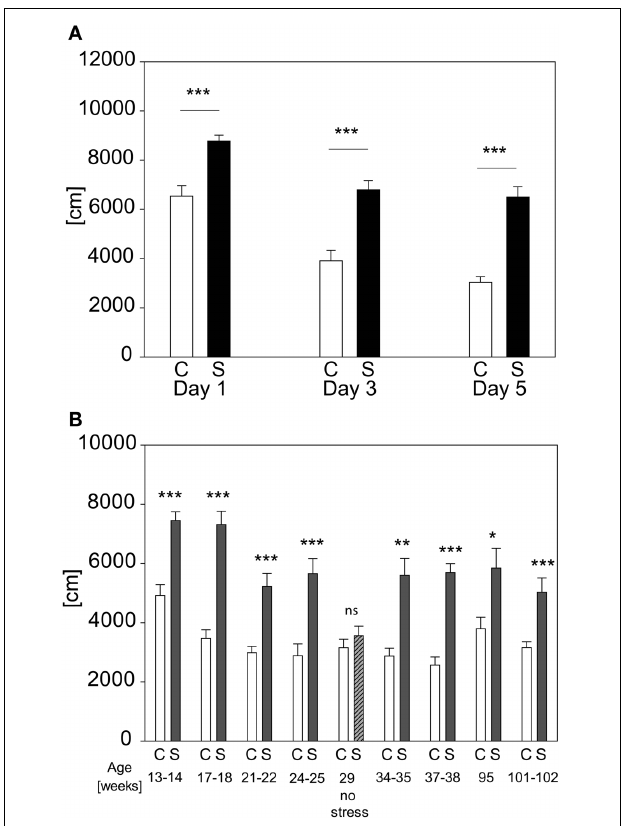
FIGURE 9 | Female and 2 year old male C57BL/6 and different inbred strains. (A) Female C57BL/6J mice were tested with the 2h restraint stress test. In both exposures females showed the expected increase in distance traveled. Aged C57BL/6J males also showed the increase in distance traveled. (B) BALB/c, C3H and 129S wildtype males were also tested with the 2h acute stress test. All of these strains demonstrated a lower locomotor activity compared to the C57BL/6 strain (horizontal shades). Both BALB/c and C3H showed increased activity after stress. Only the 129S strain did not show the behavioral response after stress exposure. Control groups, C, in white and stress groups, S, in black bars. Horizontal shades represent the 25–75% percentile of four male C57BL/6 cohorts ( n : Con = 53, Stress = 49). Dark gray shade: C57BL/6 control groups; light gray shade: C57BL/6 stress groups; Significances: ∗∗ p ≤ 0 . 01; ∗∗∗ p ≤ 0 . 001; n = 11–13 per